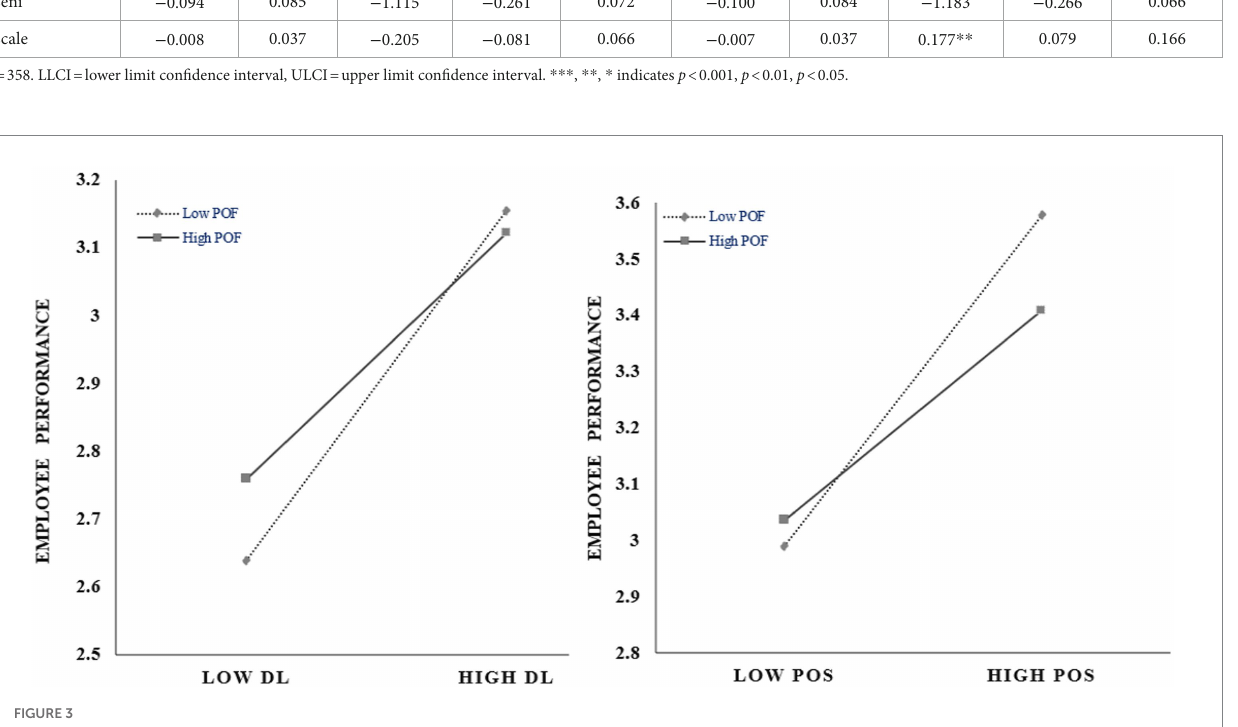
FIGURE 3 Plots for the interaction